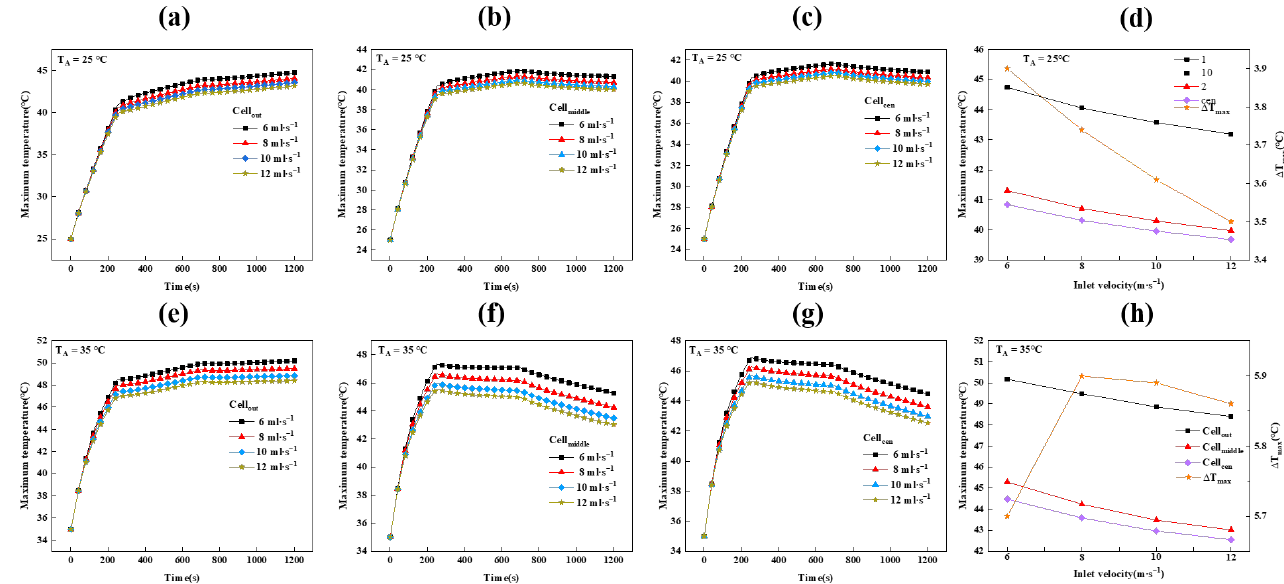
Figure 7. Temperature variation of ( a , e ) T 1 , ( b , f ) T 2 and ( c , g ) T center within the CSG–LC module at 25 and 35 °C and ( d , h ) trend of maximum temperature and temperature difference.